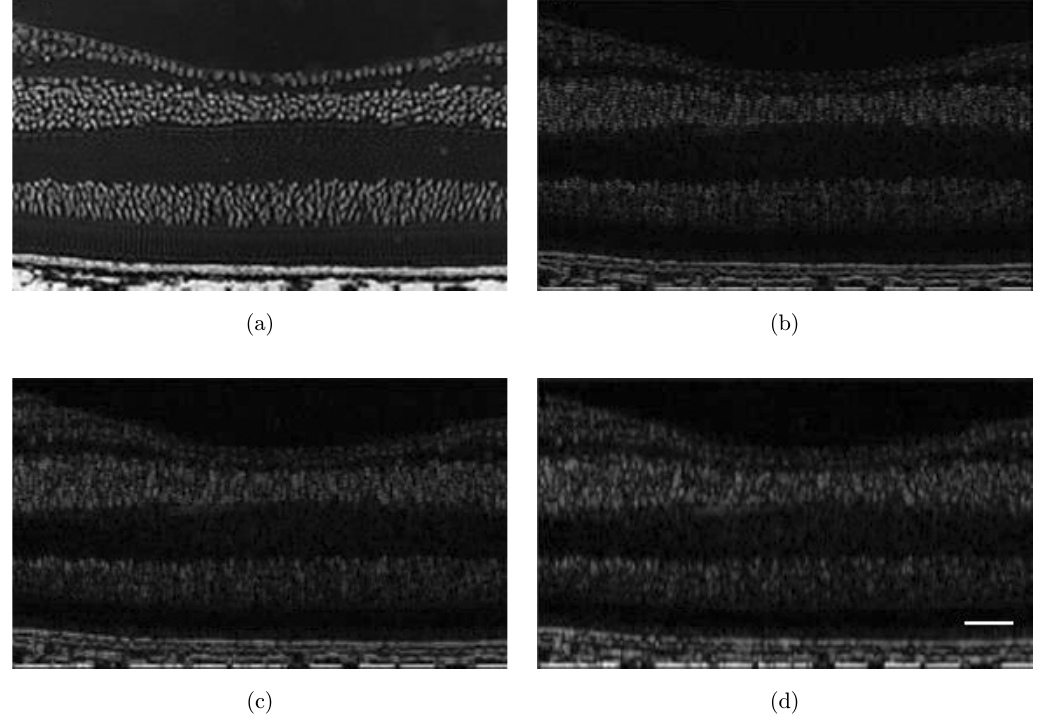
Fig. 12. (a) The input retinal image. (http://www.iupui.edu/ (cid:5) anatd502/Labs.f04/eye%20lab/pages/s94 10x 15 jpg.htm). (b), (c), (d) are the reconstructed images with a OCT axial resolution of 5, 10 and 20 (cid:1) m, respectively. Scale bar: 200 (cid:1)